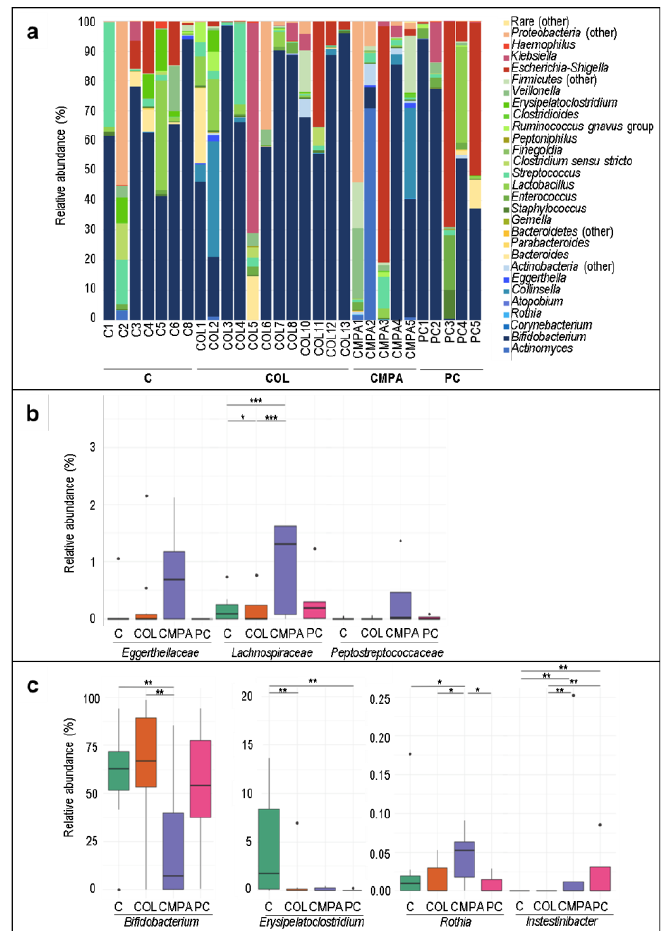
Figure 1. Bacterial composition of infant fecal samples: ( a ) Relative abundance of the major bacterial genera detected in ≥ 15% of the fecal samples; ( b ) Relative abundances of the significantly different bacterial families and ( c ) Relative abundances of the significantly different bacterial genera resulting from LEfSe analysis of the fecal samples ( N = 29). Statistical differences between the study groups are indicated with an asterisk (*, p < 0.10; **, p < 0.05; ***, p < 0.01; Dunn test). C, Control group ( n = 7); COL, Colic group ( n = 12); CMPA, Cow’s milk protein allergy group ( n = 5); PC, Proctocolitis group ( n = 5). In these boxplots, the central rectangle represents the interquartile range (IQR), the line and the cross inside the rectangle show the median and the mean, respectively; the whiskers indicate the maximum and minimum values, and the black dots outside the rectangles are suspected outliers (>1.5 × IQR).